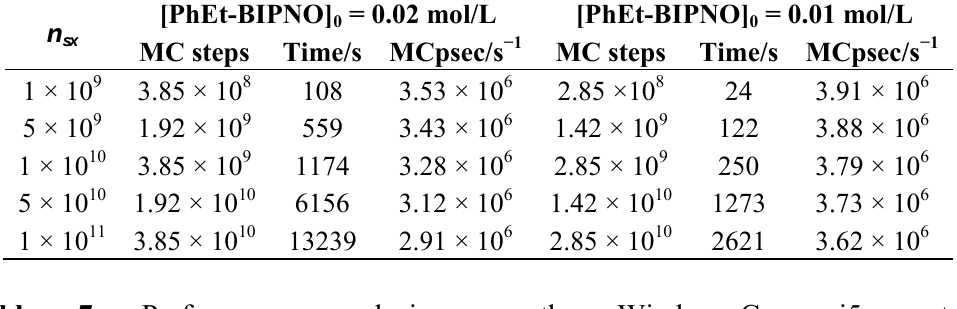
Table 7. Performance analysis on